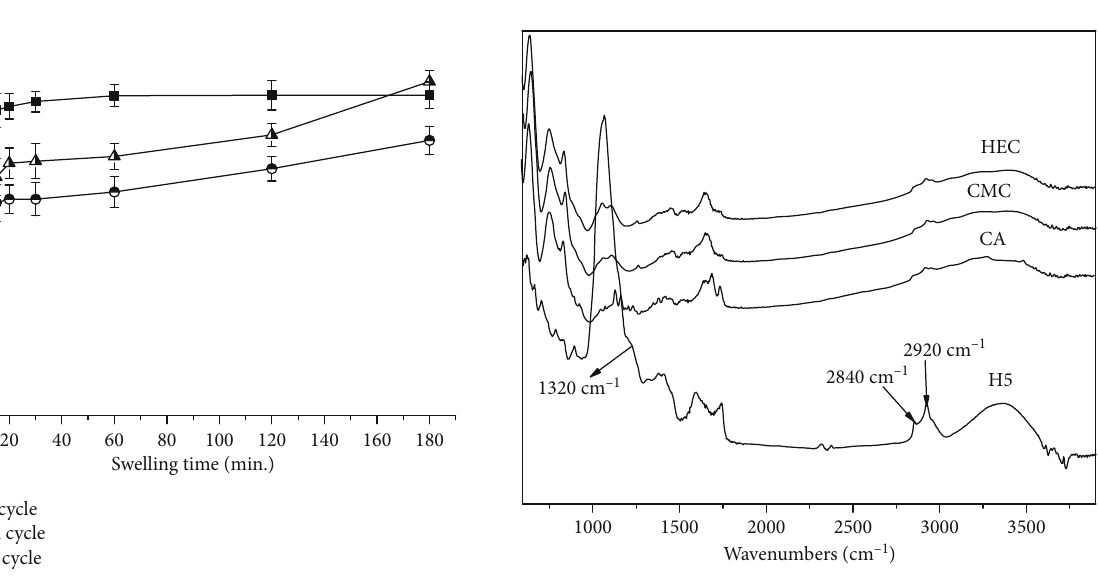
Figure 7: Water absorption capacity of hydrogel sample H5 following three consecutive swelling cycles, preceded by a drying process for each.